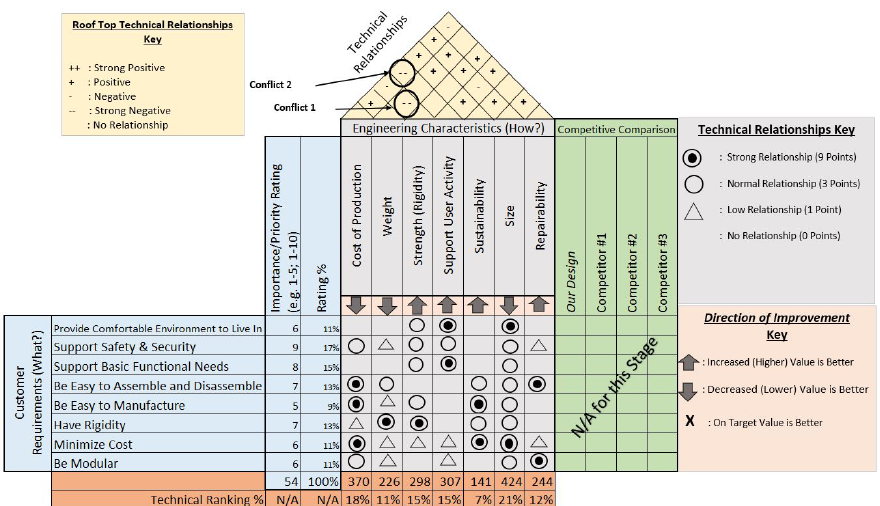
Figure 11. QFD/HOQ (Initial HOQ1) analysis of engineering characteristics to customer